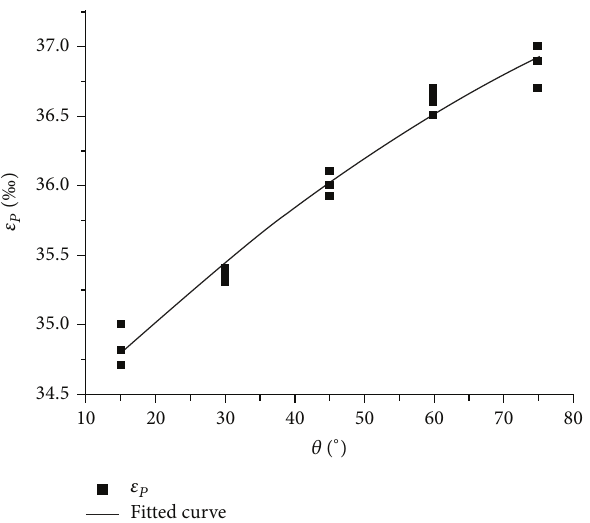
Figure 14: Coefficients of brittle stress drop versus crack orienta- tions.